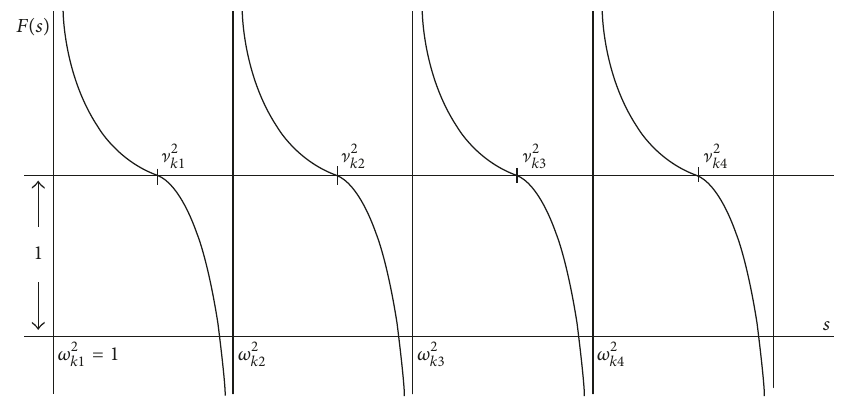
Figure 1: Graphical solution of (20).